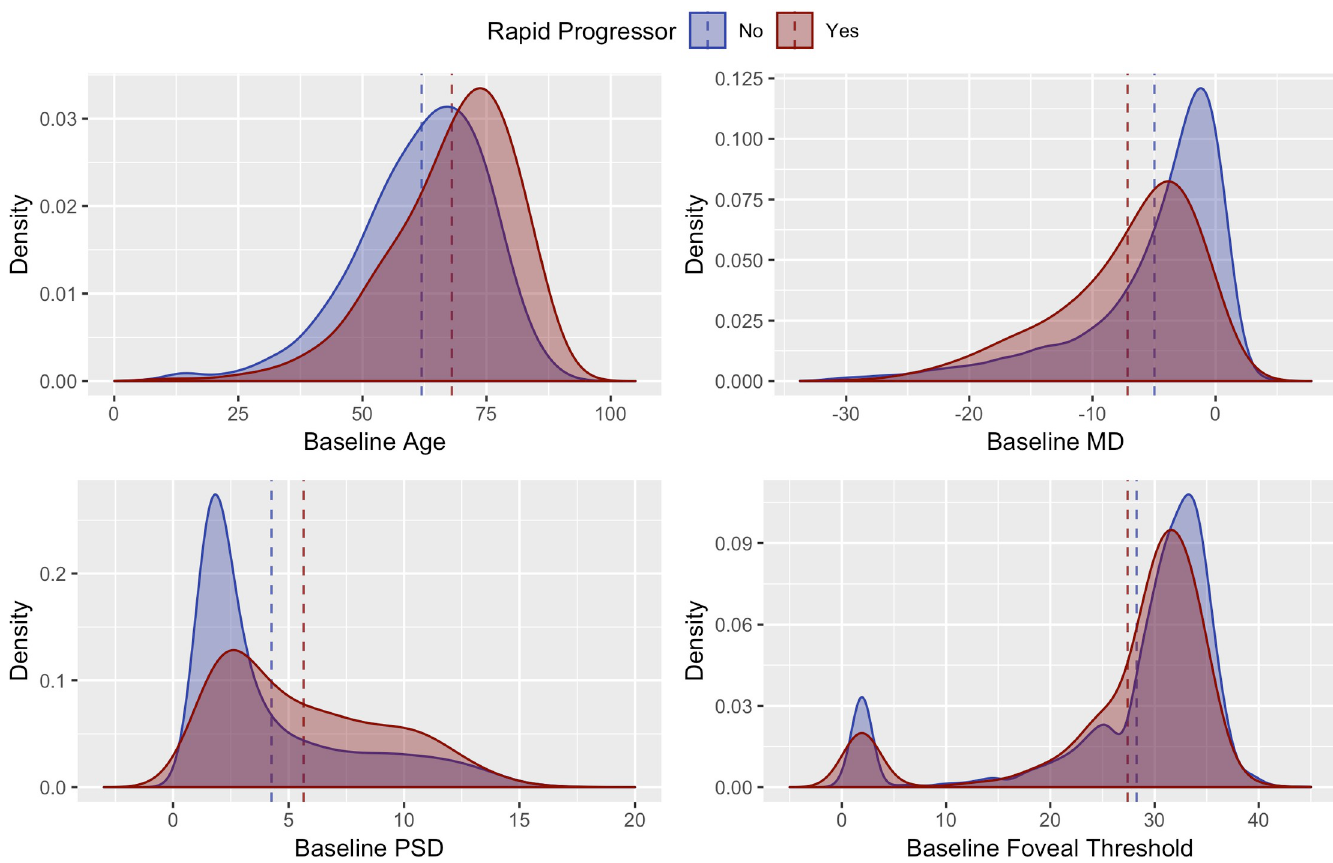
Fig 2. Density plots of rapid (red) and non-rapid (blue) progressors by age, Mean Deviation (MD), Pattern Standard Deviation (PSD) and foveal threshold at baseline. Dashed lines indicate mean values for the independent variables in rapid (red) and non-rapid (blue) progressors.